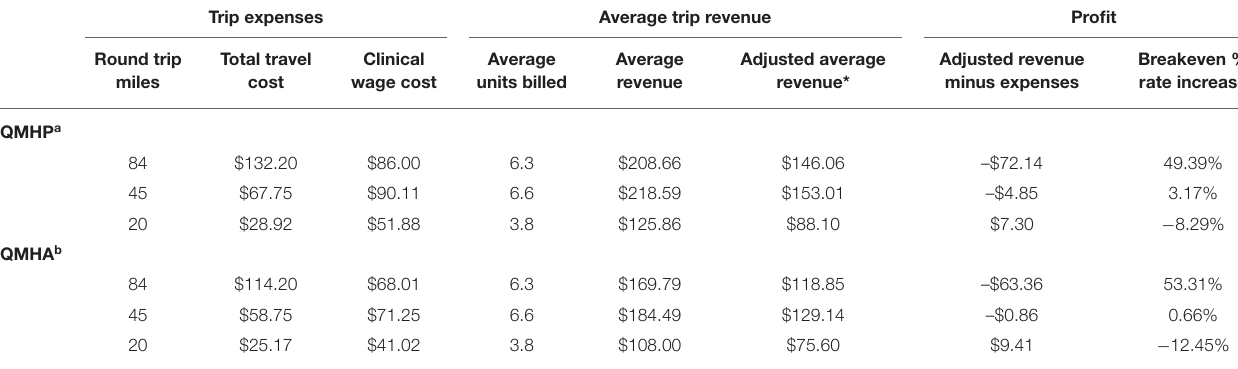
TABLE 5 | Travel costs for providing FAIR treatment throughout the catchment area of study